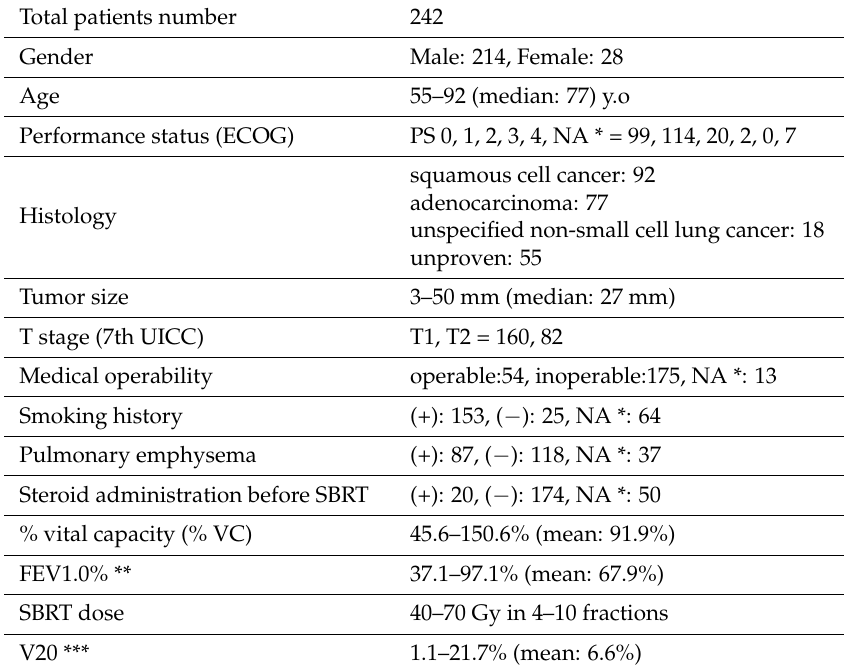
Table 1. Clinical backgrounds of the patients.